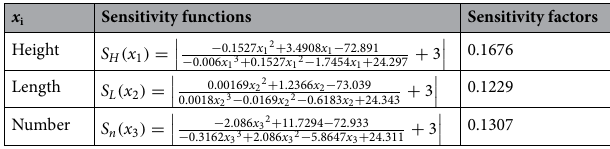
Table 3. Sensitivity function and sensitivity factors for the three factors.